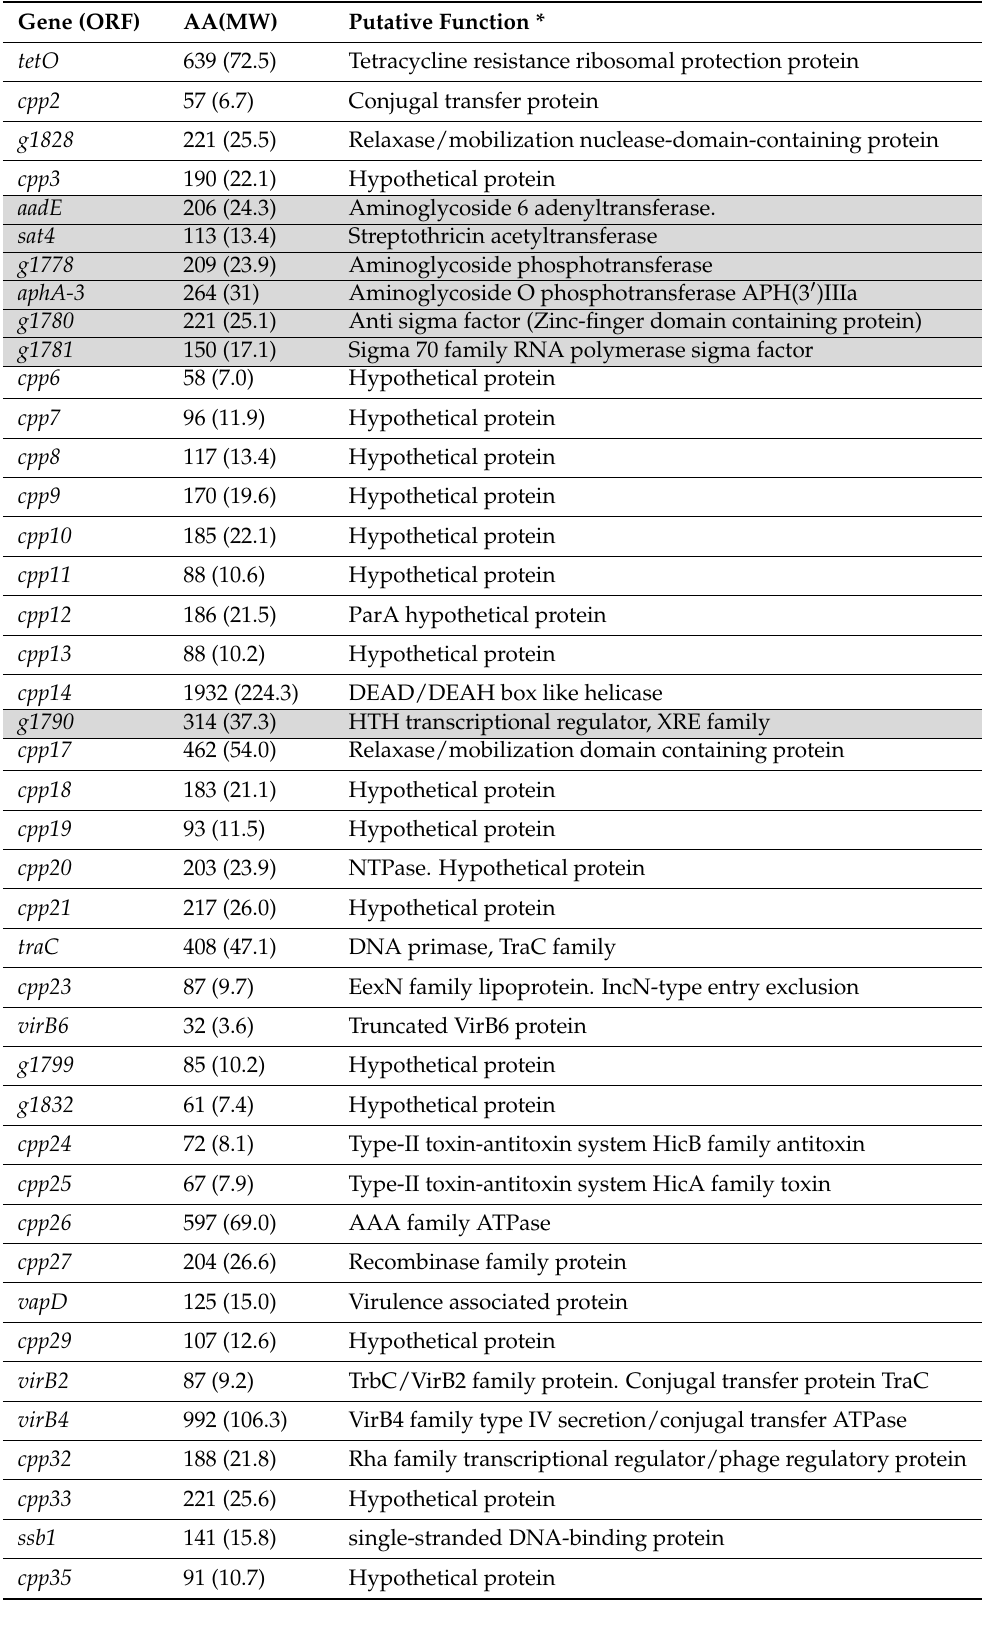
Table 1. ORFs annotated in the plasmid pCjH01. The pCjH01-specific ORFs, as compared to pTet, are highlighted (grey